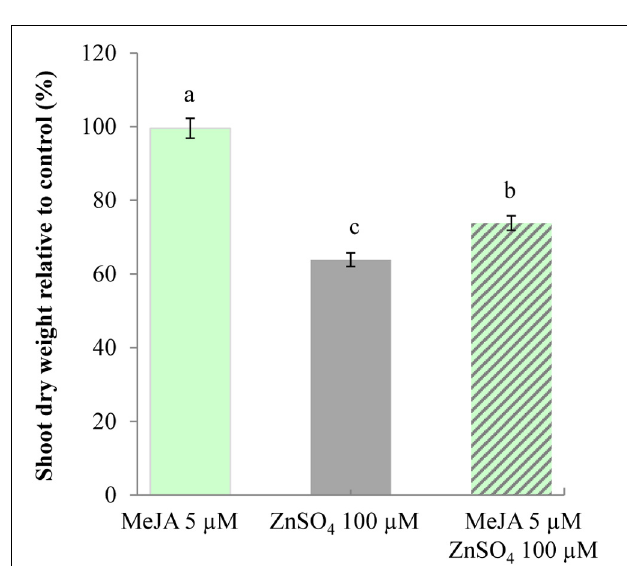
responding positively to MeJA are symbolized by boxes which are color-coded as follows: HV chs-Unit_1_m1 (light green), LE L-box (orange), AS GT1 (dark blue) and AT CAG (light blue). (B) JA-responsive motifs represented in the 500bp upstream region of the PDF1 s ( Supplementary Table 5 ) are symbolized by boxes, color-coded as follows: As -1-type (green); G-box (light violet); G-box-like (brown); GCC-box (pink).